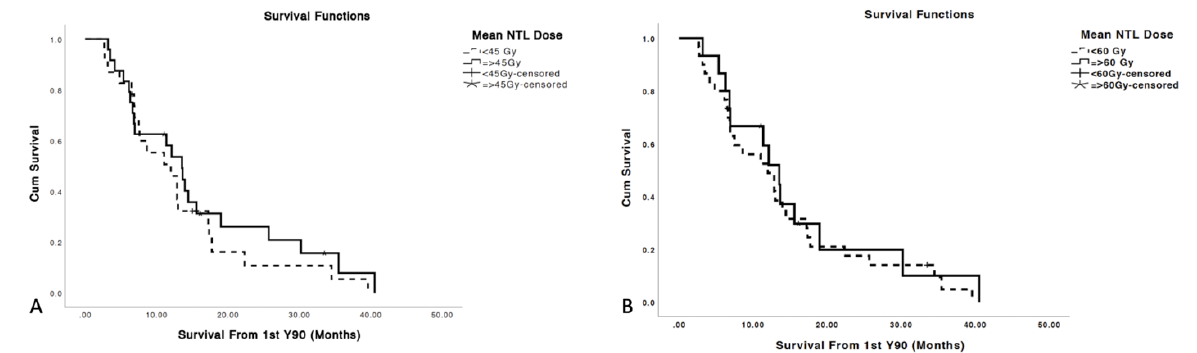
Figure 7. Mean NTL dose thresholds of 45 Gy ( A ) and 60 Gy ( B ) did not predict prolonged or shorter OS from the time of first Y90 radioembolization, p -values 0.401 and 0.547, respectively.